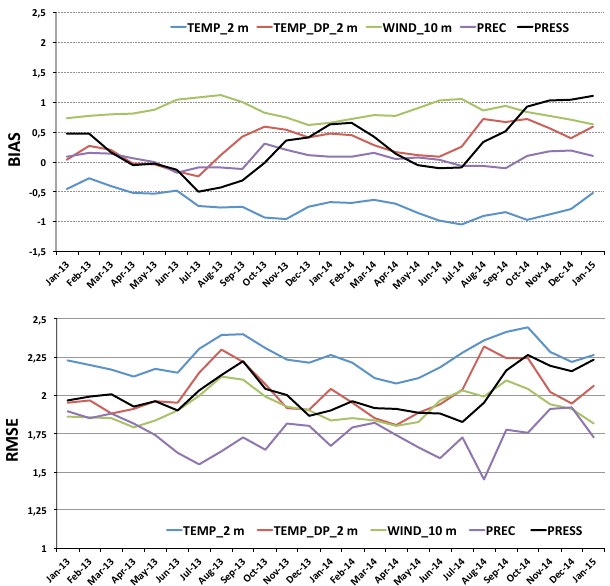
Figure 25. Equitable threat scores (ETS) and BIAS score for the BRAMS 5km operational forecast over South America. Results are runs averaged over two model domains (South America and the south-southeastern portion of Brazil) and the time period from 15 January 2013 to 15 January 2015. The results also show skill for 30 and 60h time